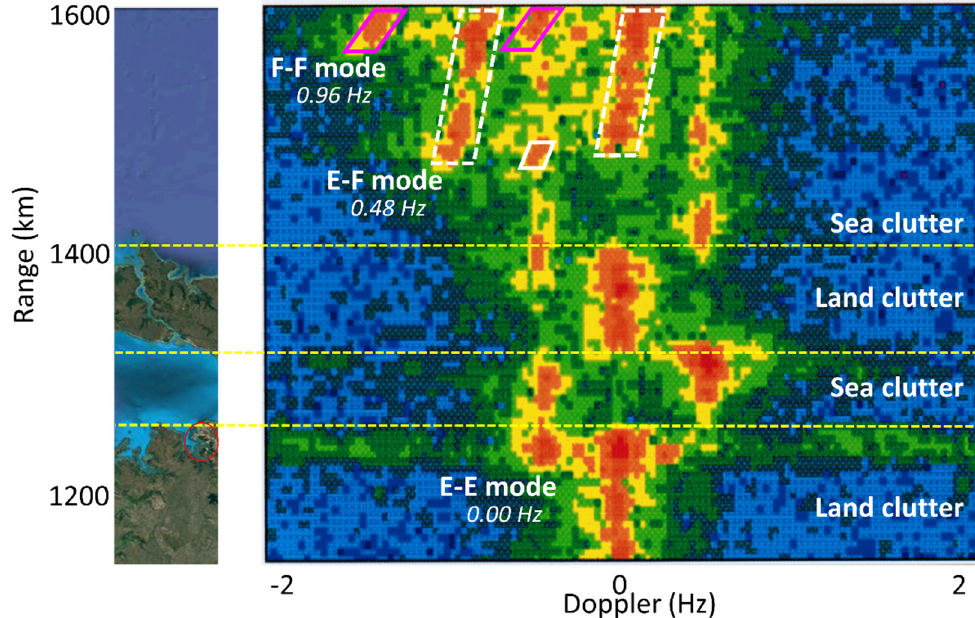
Figure 6. A range-Doppler map showing the echoes from an interrogation region straddling the coast and extending beyond a nearby island. The distinction between land and sea echoes and the presence of multiple ionospheric propagation modes are indicated, as explained in the text.